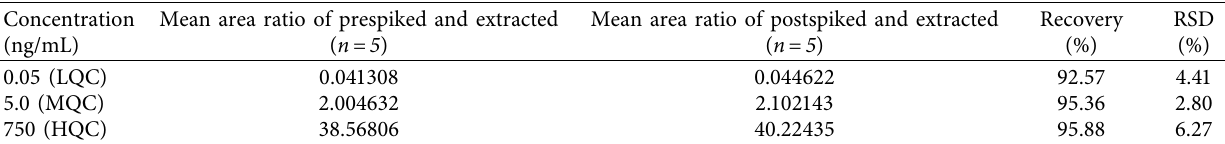
Figure 5: Representative MRM chromatograms of the liensinine and dauricine (IS) in rat plasma samples. (a) A blank plasma sample. (b) blank plasma sample spiked with liensinine in LLOQ and IS (20ng/mL). (c), (d), (e) A rat plasma sample taken 3h after oral administration of liensinine 5.0mg/kg, 12.5mg/kg, 25.0mg/kg in rats; (1) liensinine and (2) dauricine (IS) (20ng/mL). Table 2: Recovery of liensinine at three QC levels.